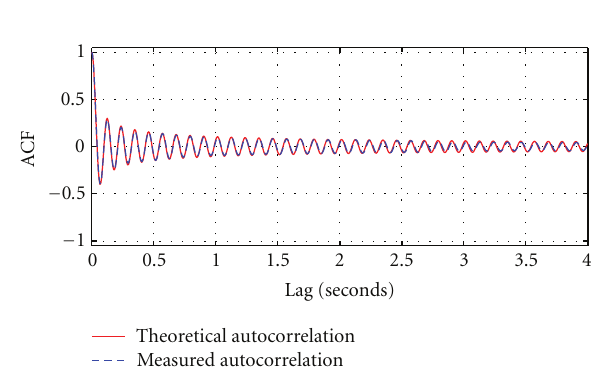
Figure 2: ACF of the generated fading samples with f D = 0 . 6 Hz, F s = 2 . 5 MHz over 60 seconds.